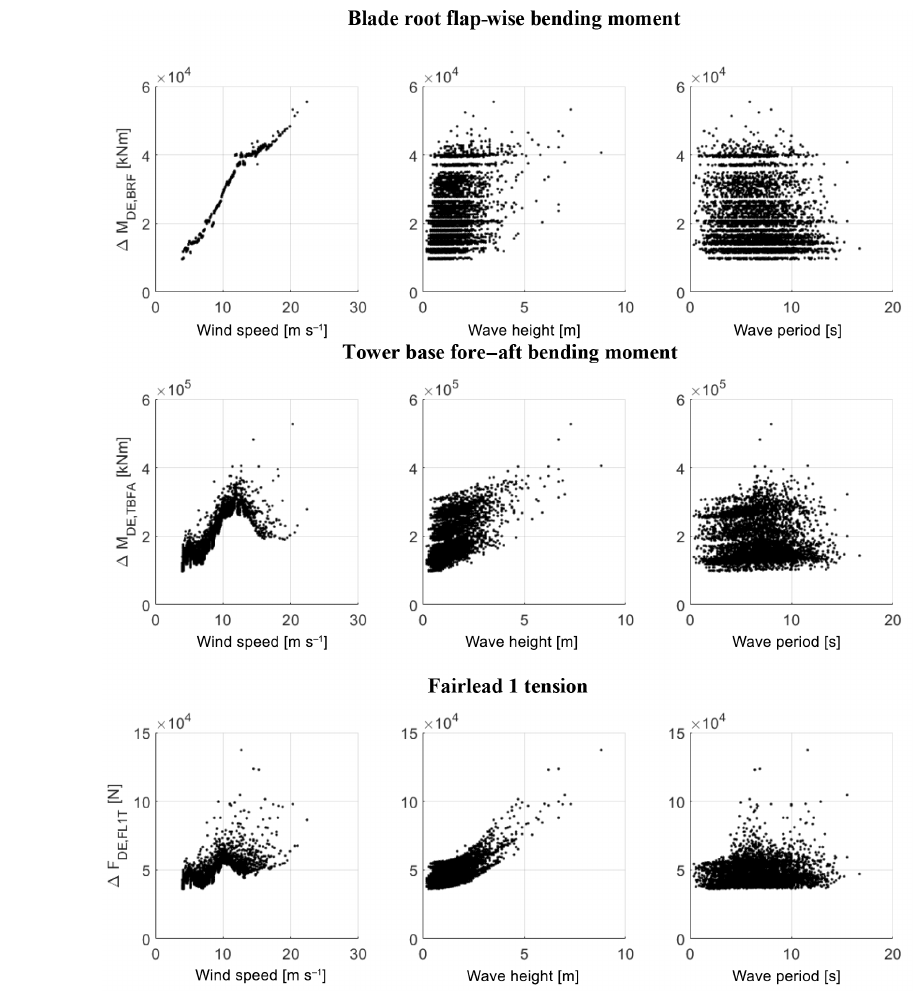
Figure 11. Scatter plots of simulation results showing influence of different environmental positions on the DEL at different